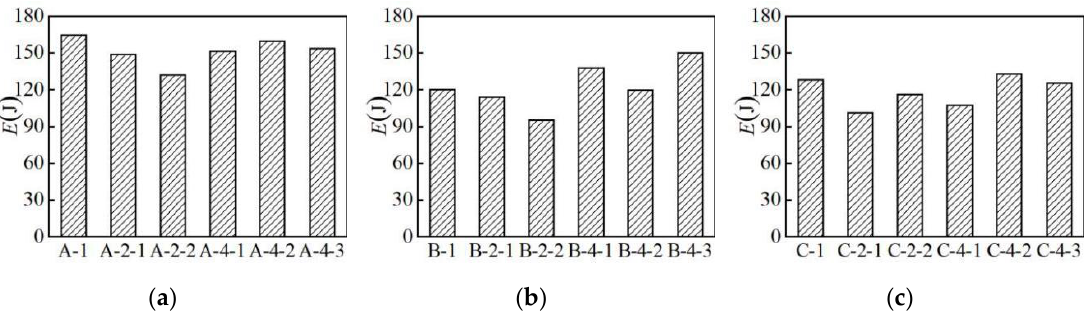
Figure 9. Influence of different loading pattern on hysteresis energy: ( a ) group A of specimens; ( b ) group B of specimens; ( c ) group C of specimens.